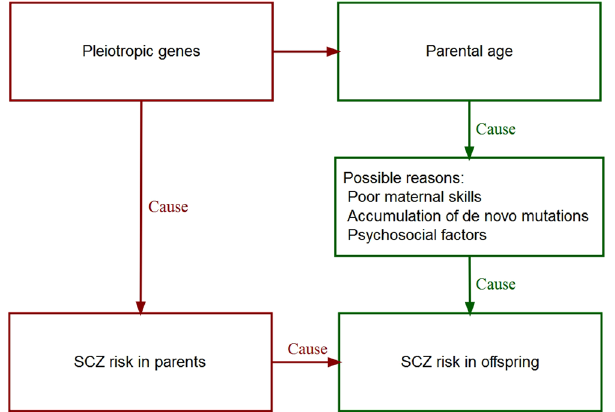
Figure 1. A flowchart of suggested mechanisms contributing to the relationship between the parental age and the schizophrenia risk in